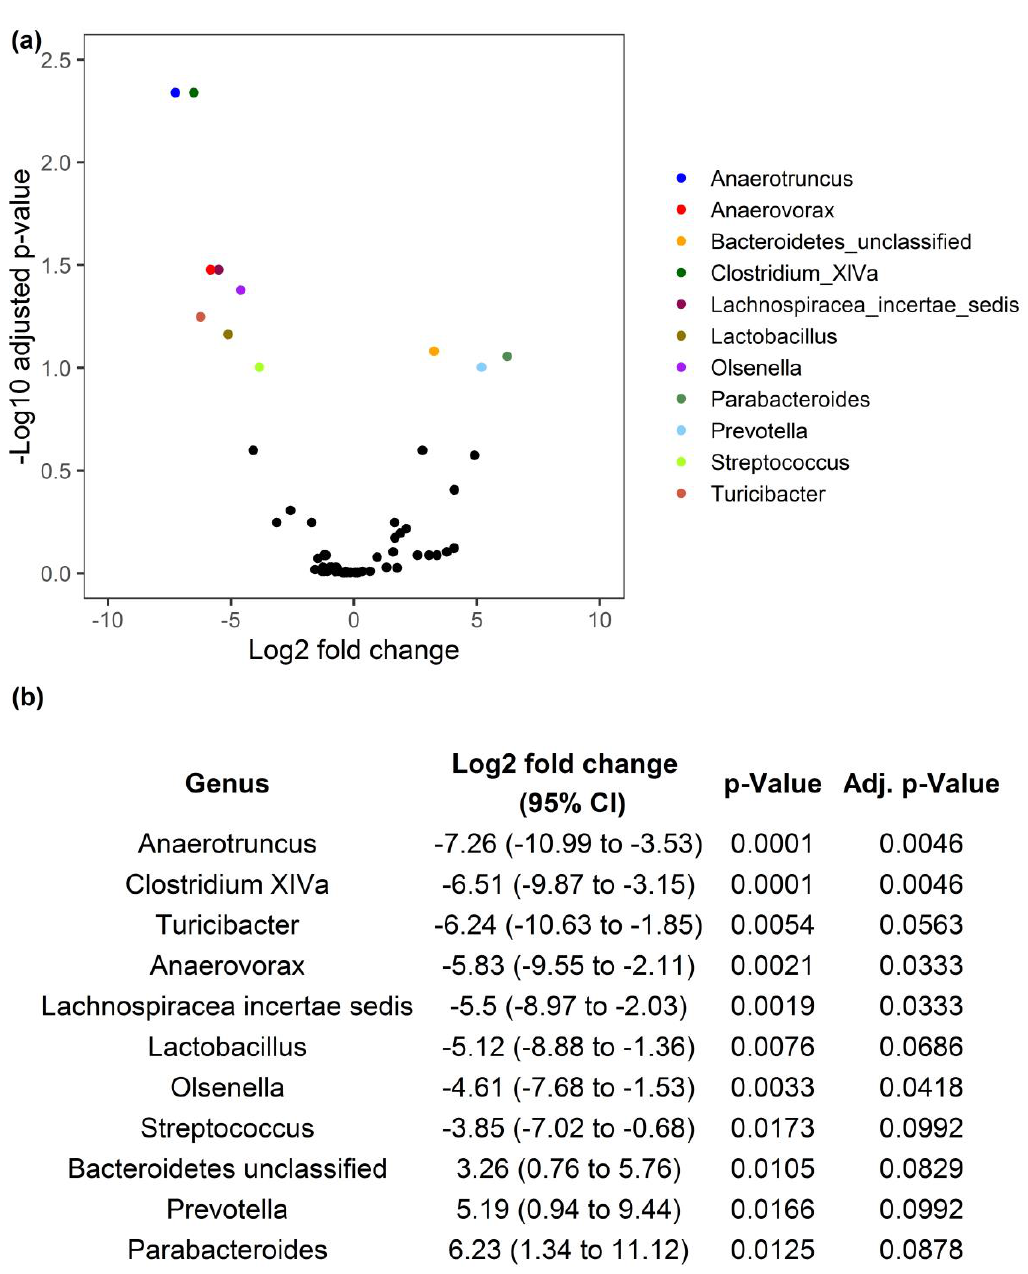
Figure 3. Univariate analysis of di ff erentially abundant genera in the mid small intestine. ( a ) The plot shows the estimated log2 fold change (FC) of operational taxonomic unit (OTU) abundance in animals receiving an α -linolenic acid rich diet (ALA) relative to animals in the control chow group (CTR). The adjusted p-value for each FC is given as the negative decadic logarithm. More significant results appear as higher values on the y axis. Black dots indicate OTUs with non-significant FC whereas di ff erentially abundant OTUs appear as colored dots. Negative FCs correspond to OTUs with a significantly reduced abundance in the ALA group compared to CTR animals. Positive FCs indicate OTUs with significantly increased abundance following ALA diet. Specific values for the log2 FC together with the corresponding 95% confidence interval (CI) and the raw and adjusted p -value are shown in ( b ).